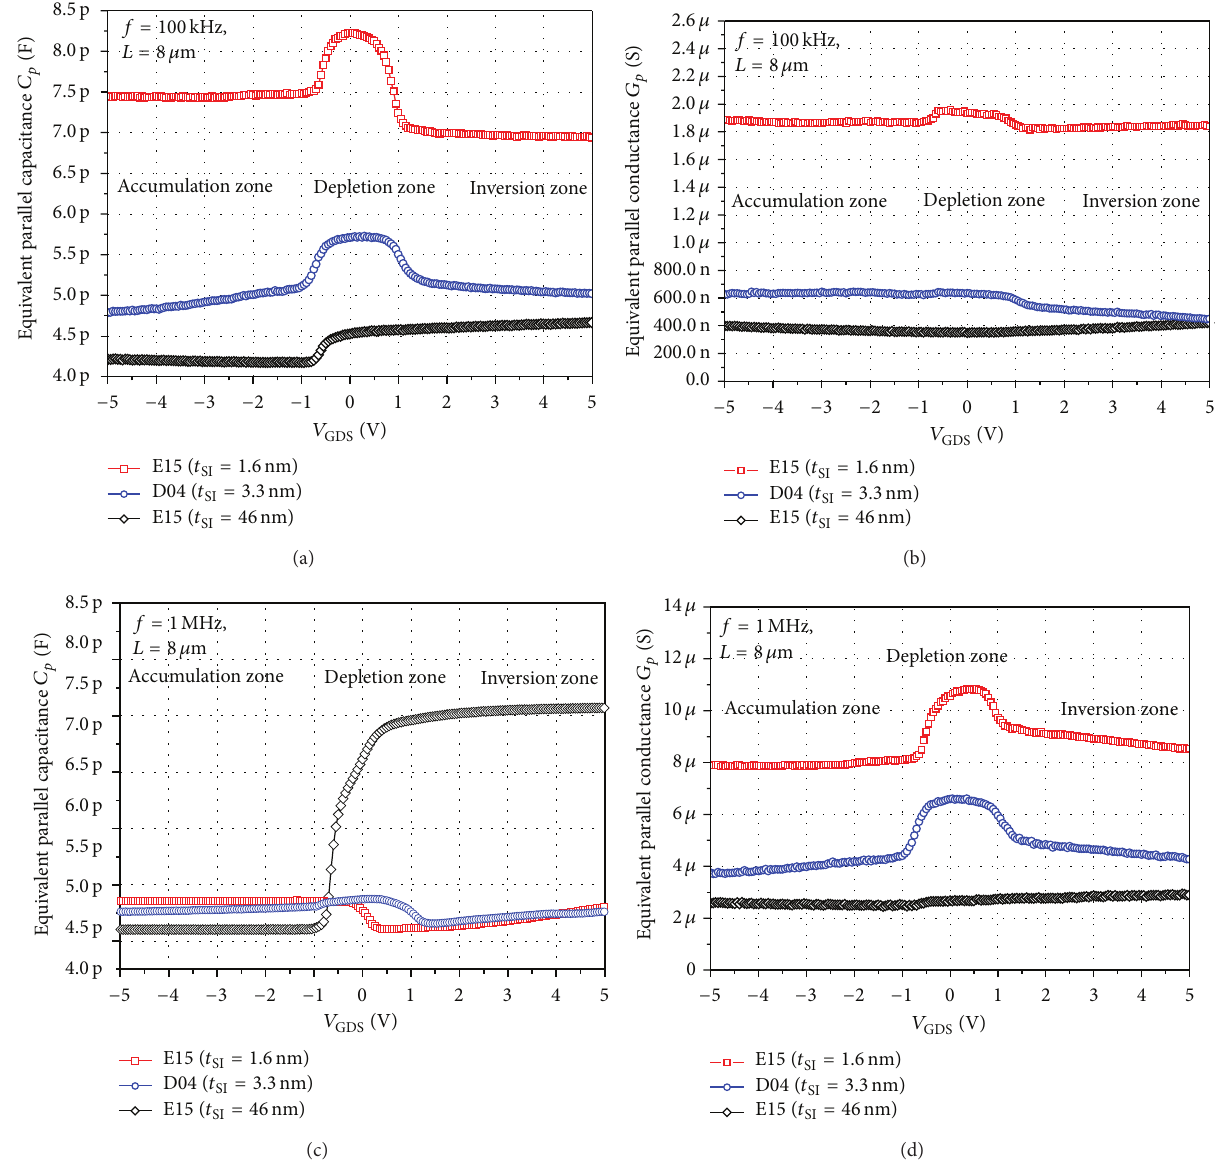
. Devices have the same gate area 𝑊 × 𝐿 SI